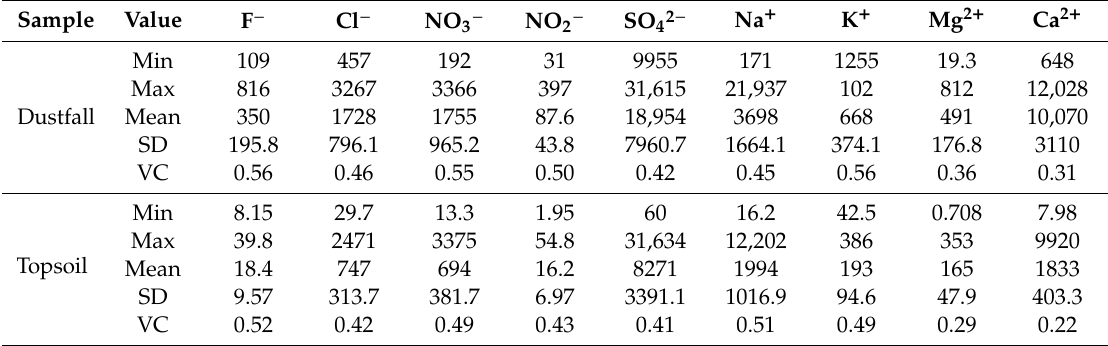
Table 1. The contents of water-soluble inorganic ions (WSIIs) in atmospheric dustfall and topsoil (mg · kg − 1 ).